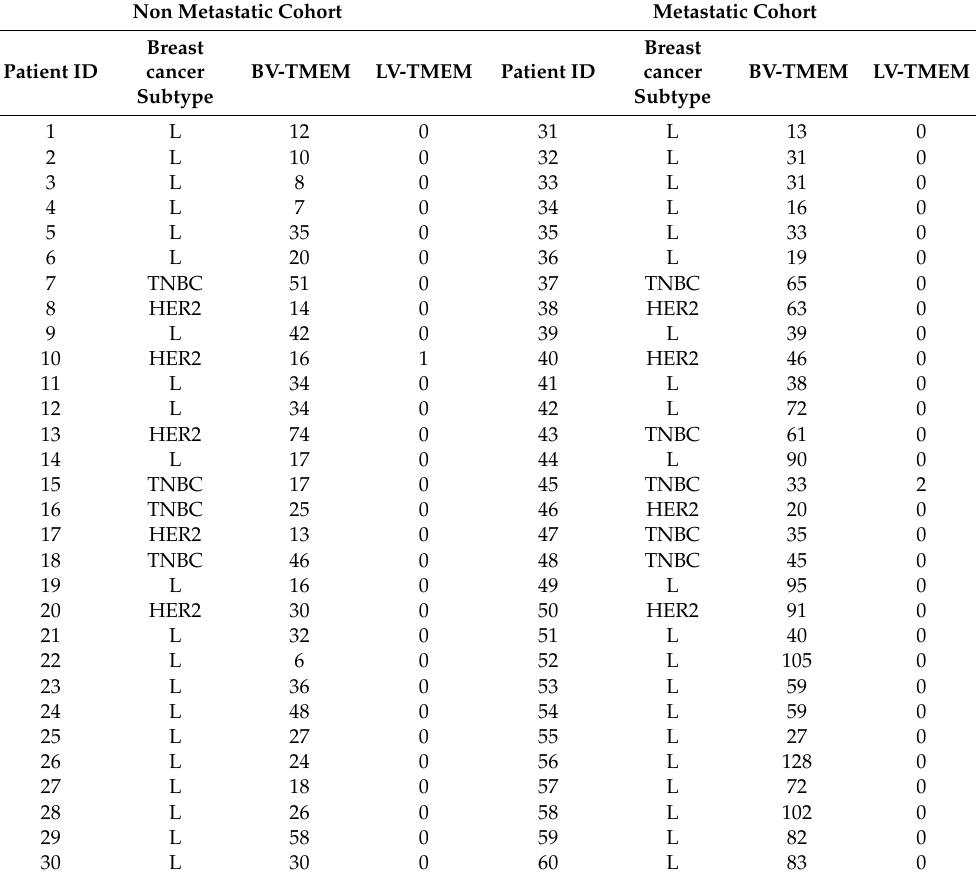
Table 3. BV-TMEM and LV-TMEM scores in the non-distant metastatic and distant metastatic patient cohort.